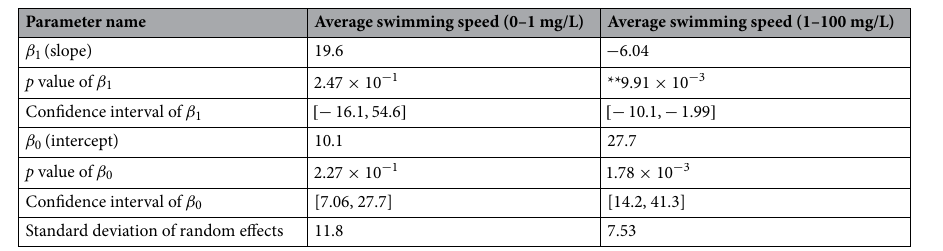
Table 3. Linear mixed model analysis for average swimming speed under free-swimming conditions. (*: p < 0.05 , **: p < 0.001 , ***: p < 0.001 ).